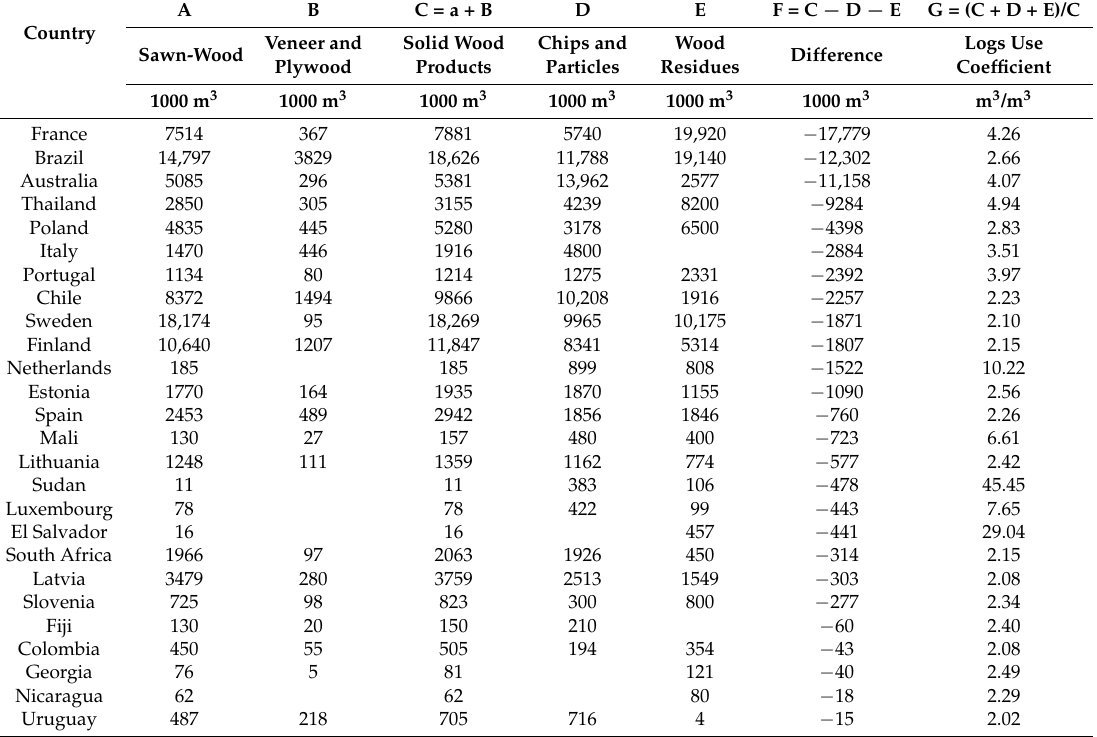
Table 4. Production of solid wood products (column C), chips and particles (D), and wood residues (E), their difference (F), and the resulting coefficient of wood use per solid wood product output (G, sum of all outputs divided by the solid wood output) in year 2015. The countries are ranked according to the value in column